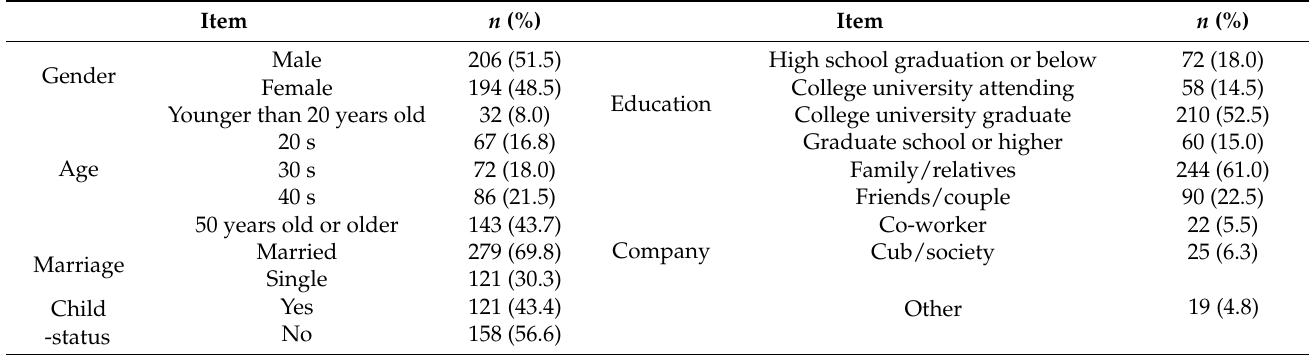
Table 2. Characteristics of the